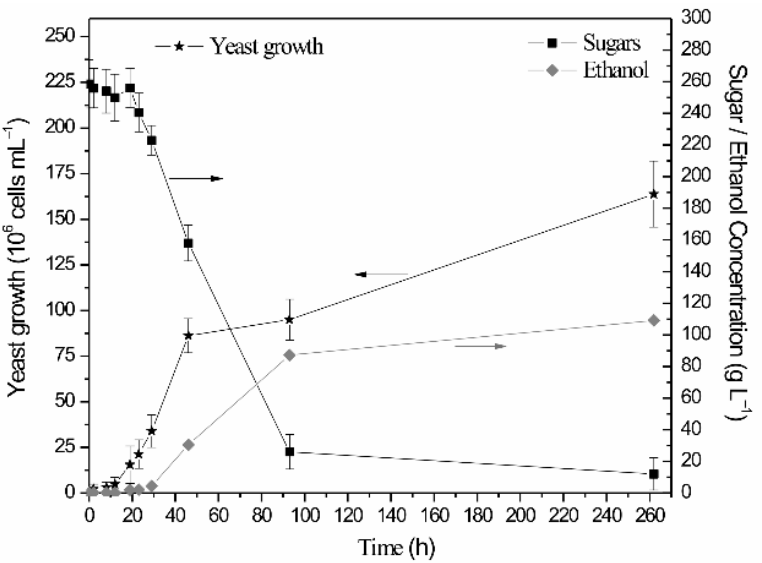
Figure 3. Profile of yeast growth, sugar depletion and ethanol production through time using a high sugar concentration substrate (derived from synthetic medium cyanobacterial-based biomass treated with H 2 SO 4 at 120 min hydrolysis time supplemented with raisin residue extract).